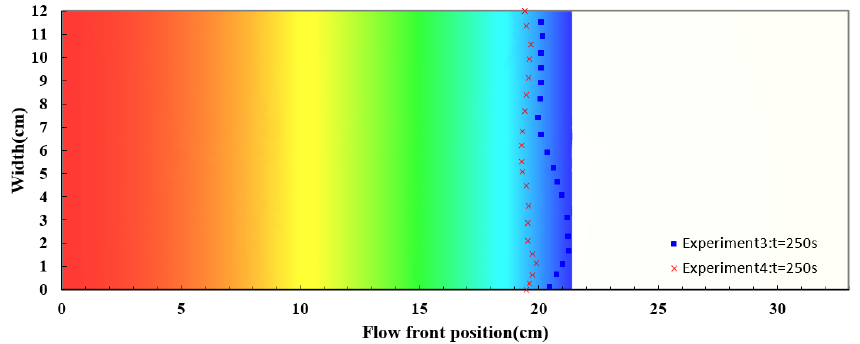
Figure 22. Comparison between experimental and simulated flow front positions in the case study of seven-layer fiber preform.